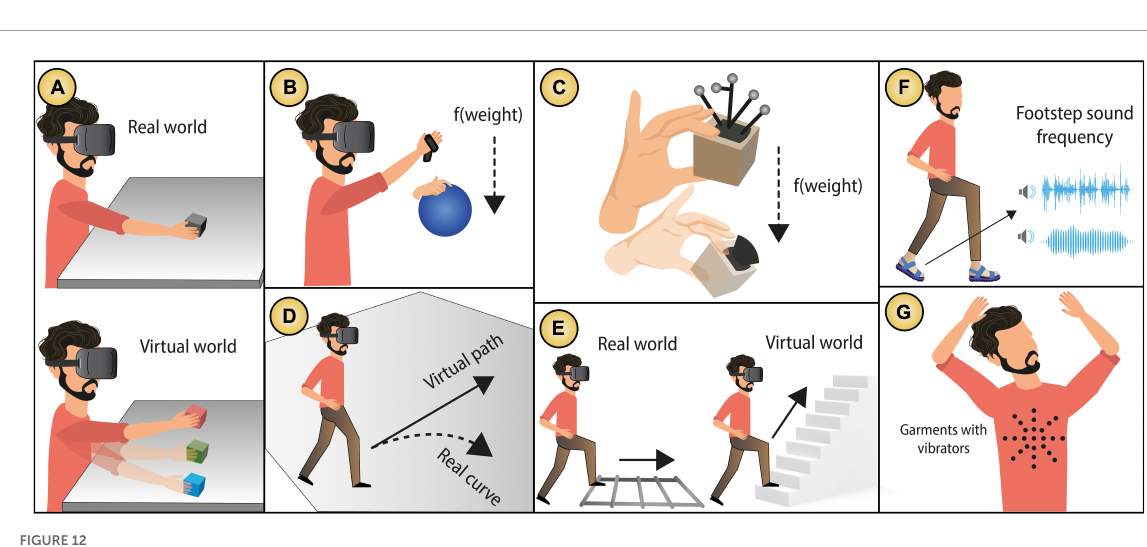
FIGURE12 Examples of outcome augmentation technology: Retargeting techniques modulating (A) object quantity (Azmandian et al., 2016), (B,C) object weight (Rietzler et al., 2018; Samad et al., 2019), (D) navigation direction (Sharif et al., 2001), (E) navigation elevation (Nagao et al., 2018), and body perception (F,G) (Tajadura-Jiménez et al., 2019, 2020). Images based on the original publications.